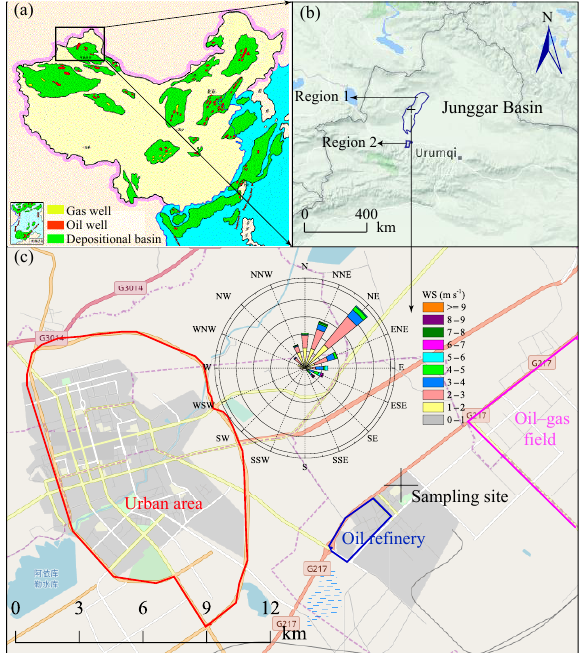
Figure 1. The spatial distribution of oil- and gas-bearing basins in China (a) and the terrain of the study area (b) . The sampling site is about 11km away from the urban area and located to the northeast of an oil refinery plant and southwest of an oil and gas field. The northeasterly winds prevailed during the sampling periods (c)